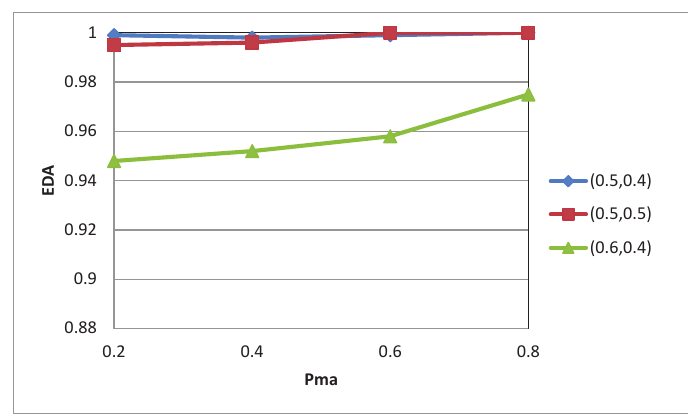
= r , α = 0.1 and β = 0.02. e c